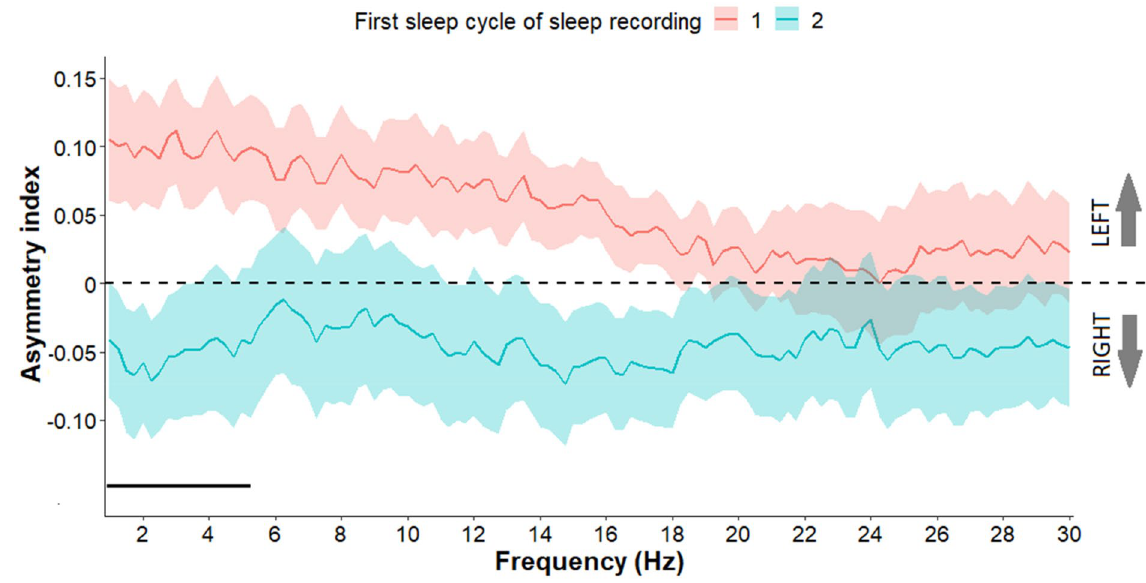
Figure 5. Asymmetry index values (Mean + / − SE) in frequency range 1–30 Hz in the first sleep cycles of sleep recording 1 and 2. In sleep recording 1 greater rightward asymmetry was observed in the frequency range of 1–5.25 Hz, compared to the sleep recording 2. Frequency bins below the statistical threshold (all p s < 0.05, fulfilling the criteria of a significant Rüger area) are illustrated by a black horizontal line.